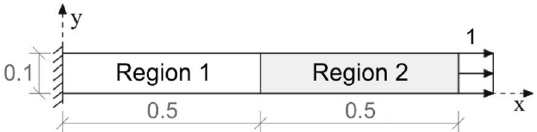
Figure 18. Representation of the problem solved in example 4.